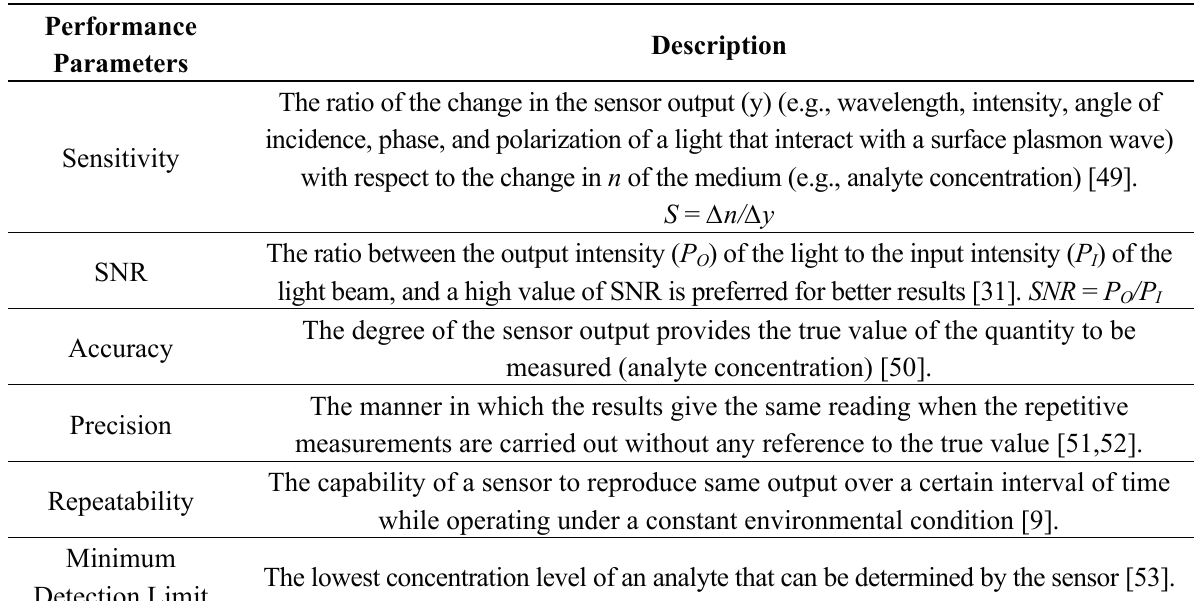
Table 1. Description of different performance